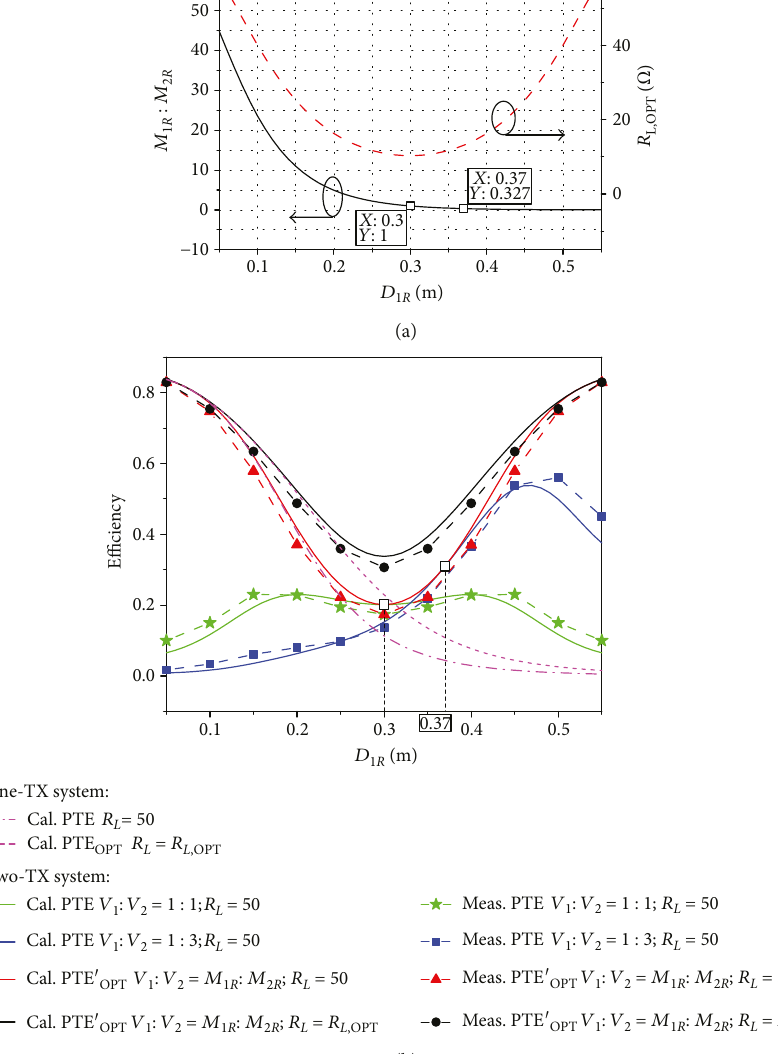
Figure 10: E ffi ciencies versus transfer distance when two TXs and a single RX are arranged face to face to construct a complete system: (a)mutualinductanceratioandoptimalloadforthehigheste ffi ciency;(b)calculatedandmeasurede ffi ciencyvaluesunderdi ff